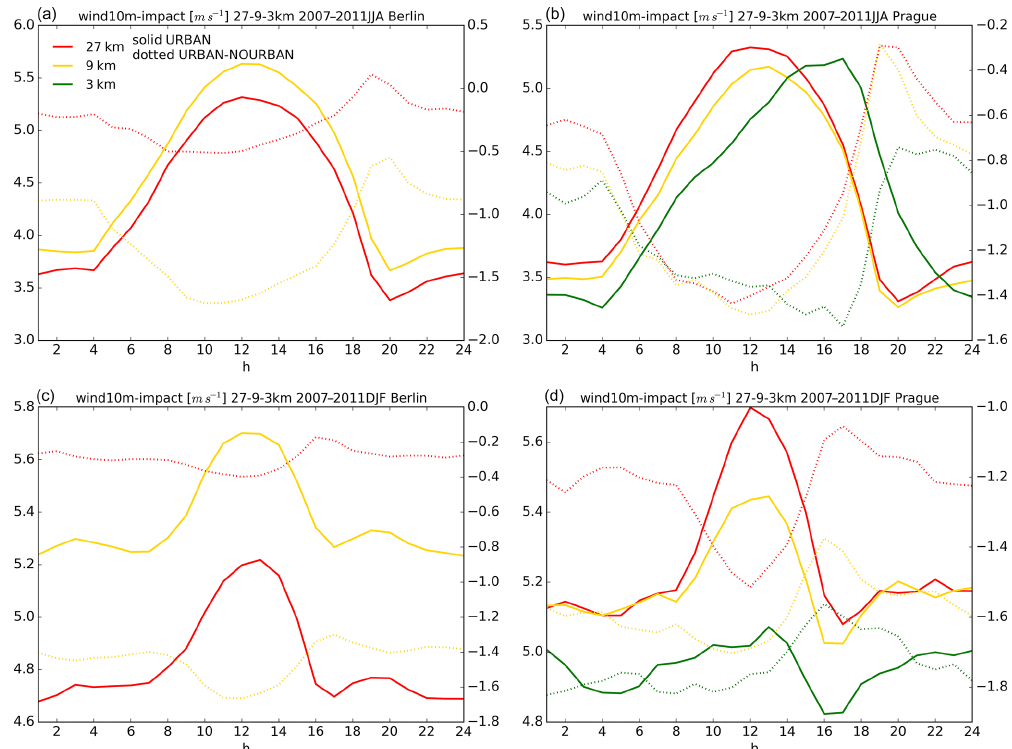
Figure 12. Impact of urban surfaces on the diurnal cycle of the 10m wind speed in ms − 1 for JJA (a, b) and DJF (c, d) for the three resolutions (27km – red, 9km – orange and 3km – dark green). Solid lines are the absolute values (left-hand y axis) from the URBAN model experiment; dashed lines represent the urban impact (right-hand y